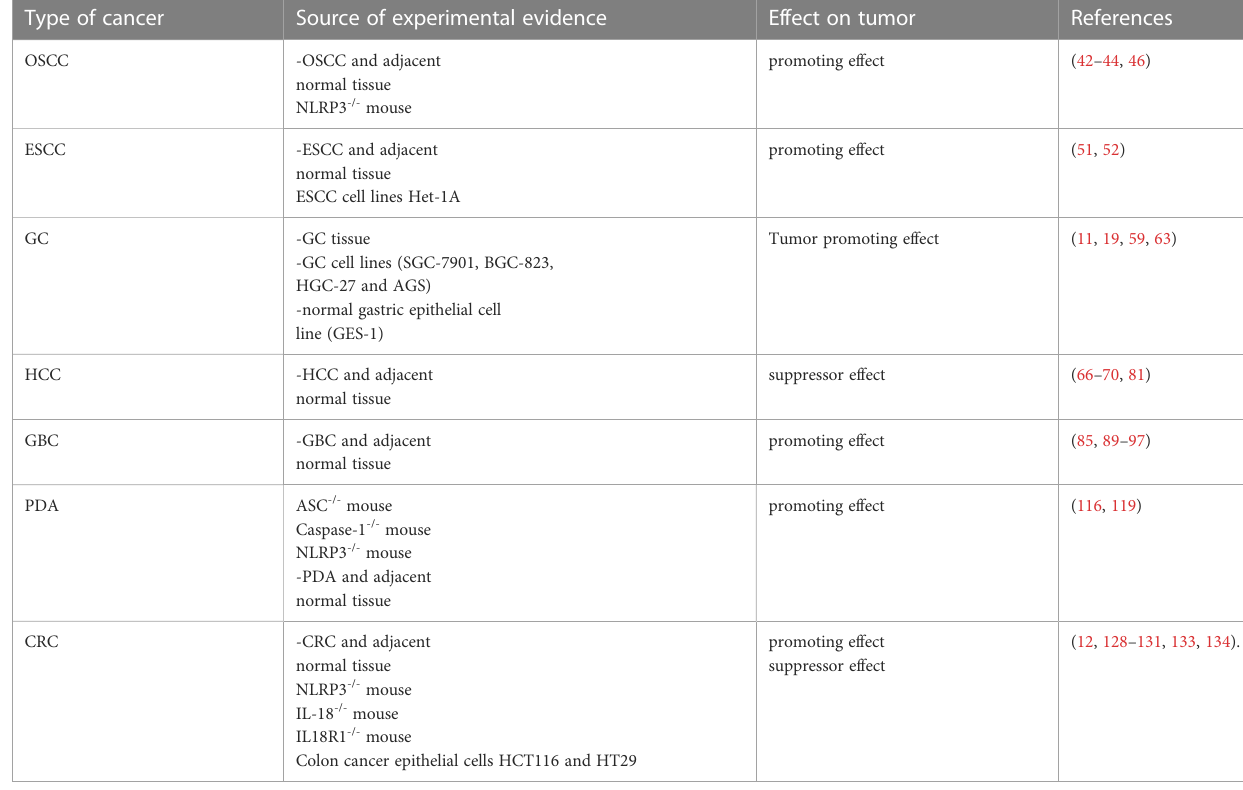
TABLE 2 Role of NLRP3 in fl ammasome activation or suppression in cancer development. Type of